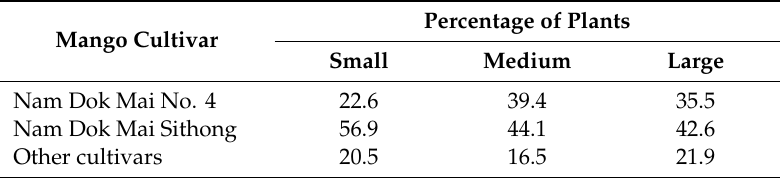
Table 3. Disease incidence (%) ( n = 30) of ‘Nam Dok Mai No. 4’ and ‘Nam Dok Mai Sithong’ mangoes cultivated in 5 orchards in the Phetchabun province during storage at ambient conditions (25 ◦ C, 60–70% RH ) .